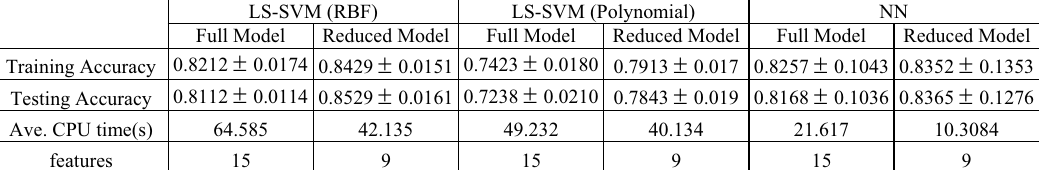
Table 3. Average classification accuracy of multi-class IC packaging type dataset with NN, RBF and Ploynomial